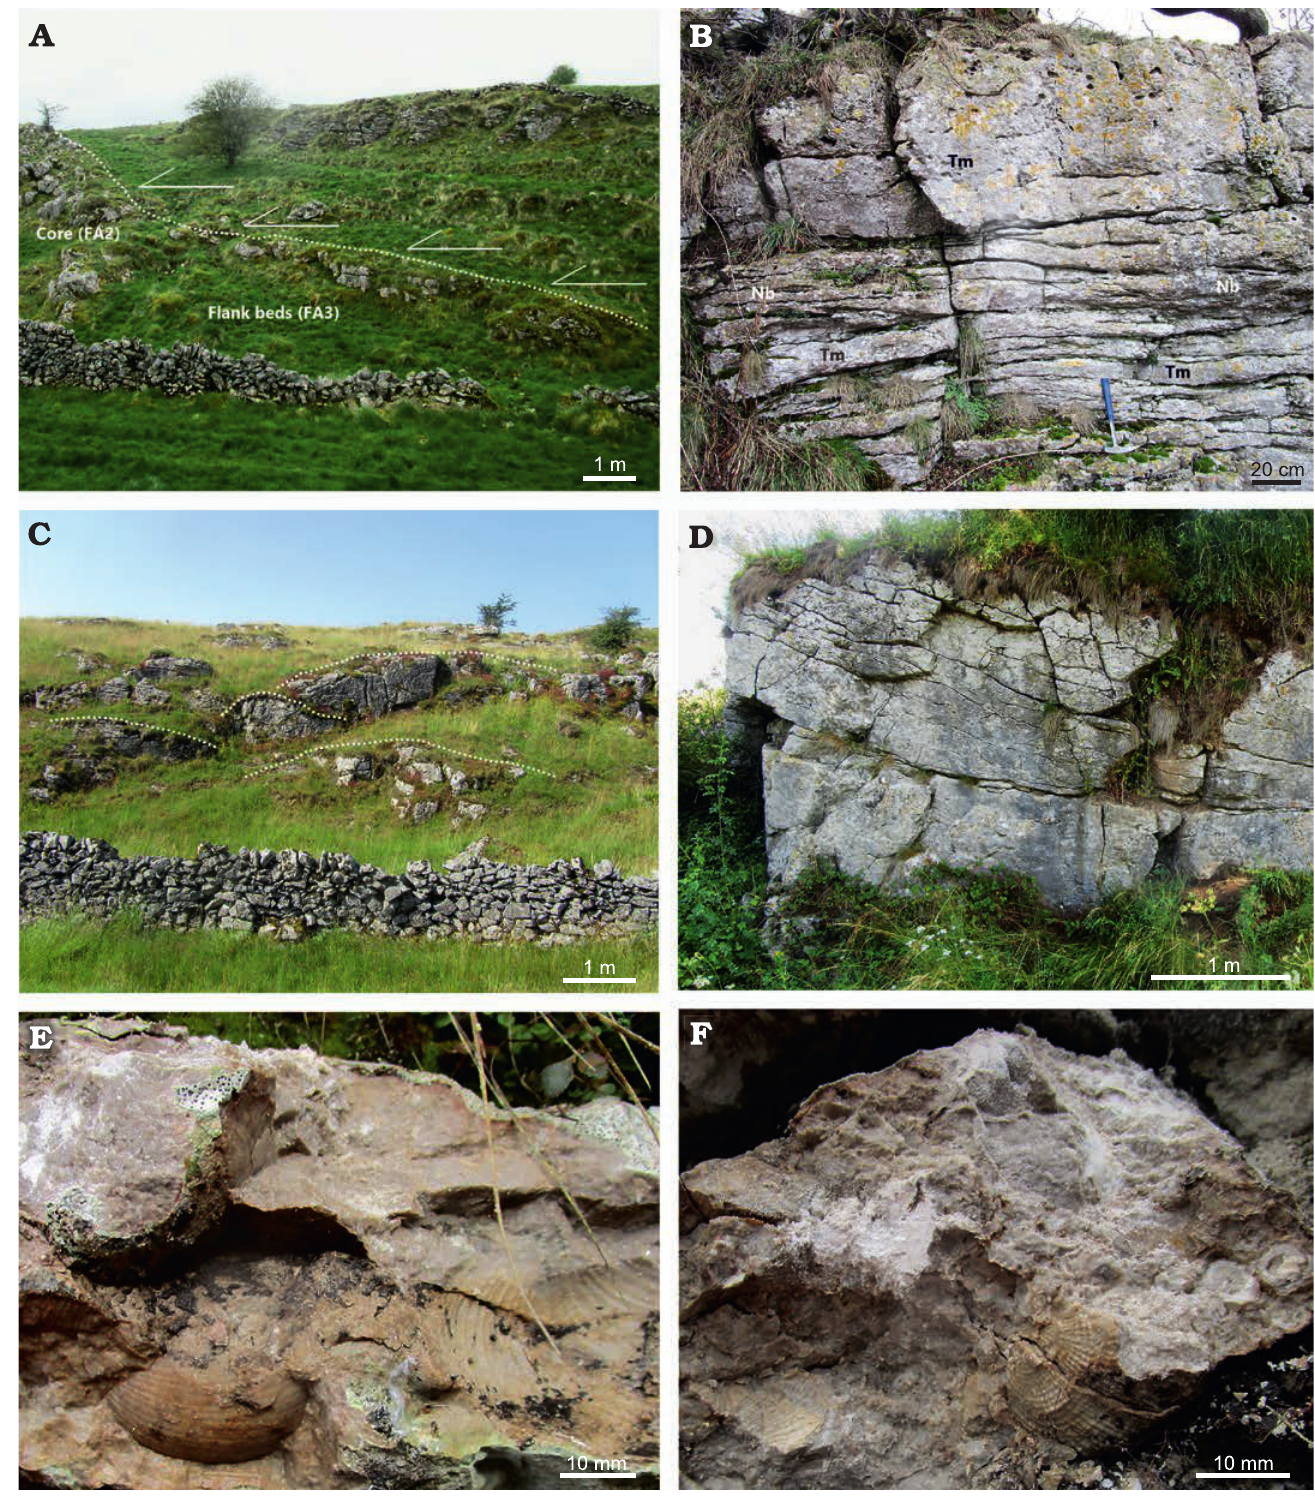
Fig. 4. Outcrop photographs from the Ricklow Quarry site, Monyash, England. A . Eyam Limestone Formation beds onlapping (solid line arrows) the mud mound complex capping surface (dotted line). The boundary is marked by subaerial exposure features. B . Nodular packstone beds (Nb) and tabular massive mounds (Tm) forming the basal facies association (FA1) of the mound complex. C . Lens-shape mounds accreting to form the mound com- plex core (FA2). Dotted lines indicate capping surface of mounds. D . Detail of inclined flank beds (FA3) dipping eastward (inclination 35–25°) on the south-eastern edge of the mound complex. E . A ventral valve of Latibrachythyris cf. crassa (De Koninck, 1843) (below) and reticulate productide in life position (above) in a nodular packstone bed from the basal FA1 unit of the mound complex. F . Dorsal valve of a species of Antiquatonia from the mud mound complex core (FA2). The valve is part of a specimen in life position. The specimen is surrounded by other brachiopod shells and crinoid